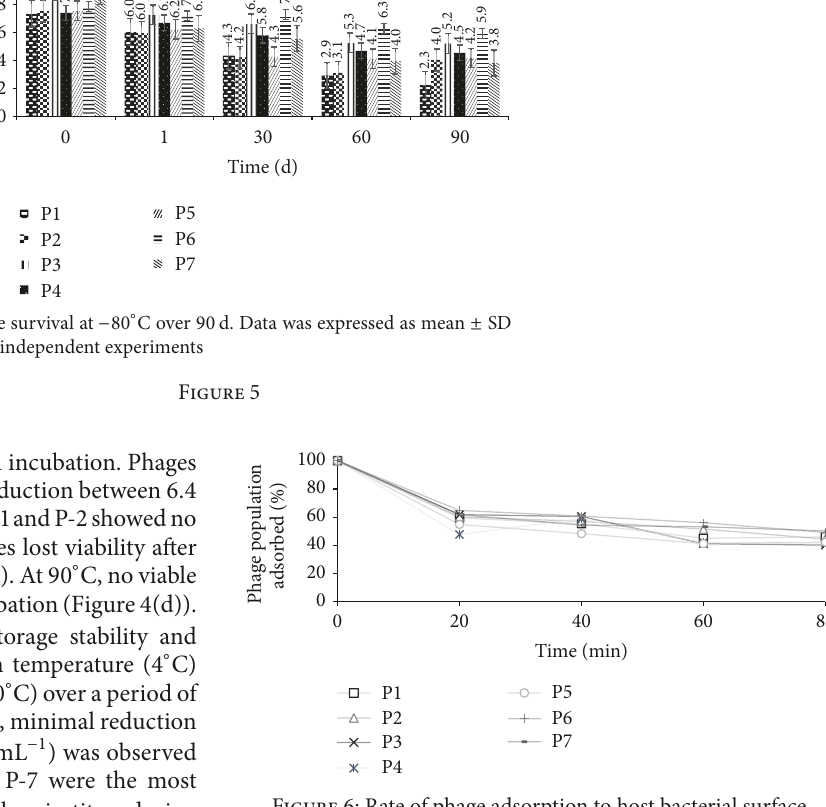
Figure 6: Rate of phage adsorption to host bacterial